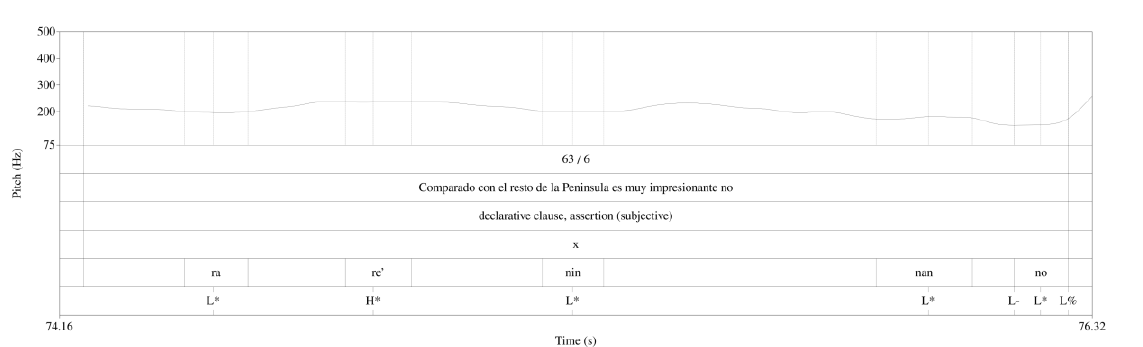
Figure 1. ¿Comparado con el resto de la Península es muy impresionante, ¿no? realized with a level contour over the tag